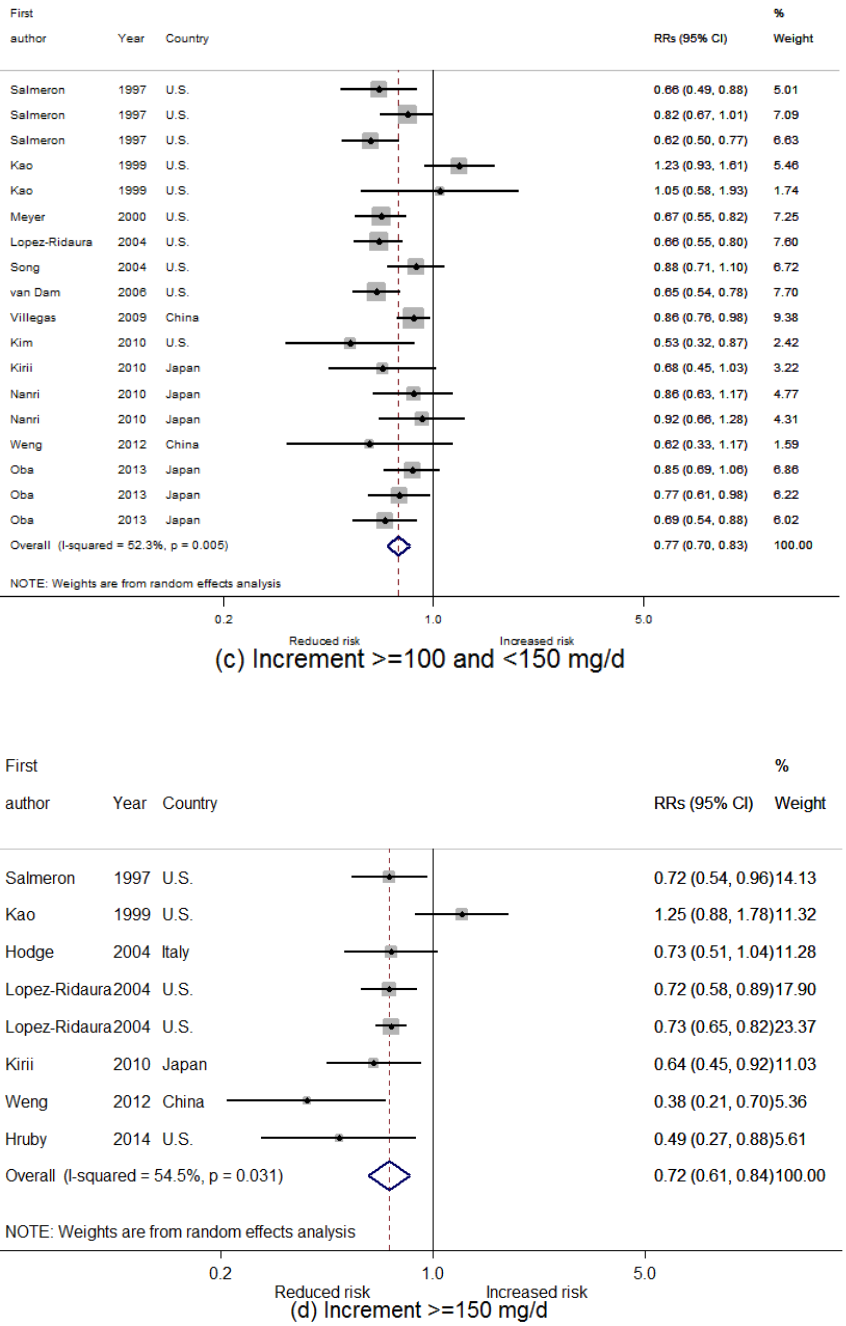
Figure 3. Relative risks (RRs) for risk of T2D incidence for different dietary magnesium increment categories: ( a ) <50 mg/day; ( b ) 50–99 mg/day; ( c ) 100–159 mg/day; ( d ) ≥ 150